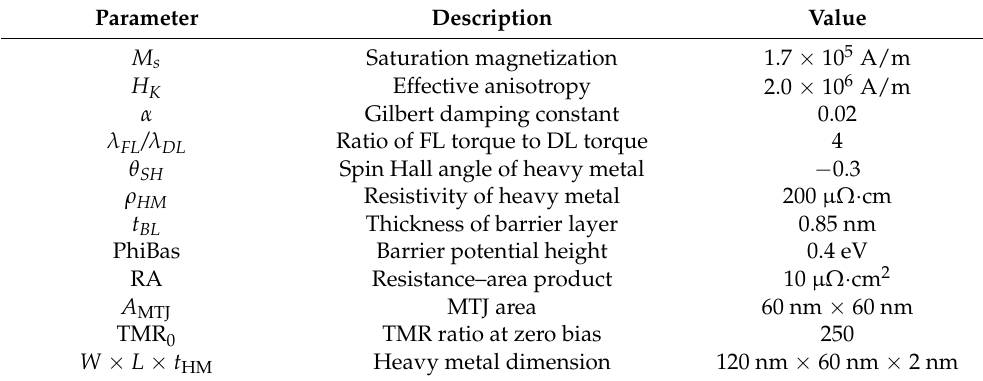
Table 1. The simulation parameters for 3T2M